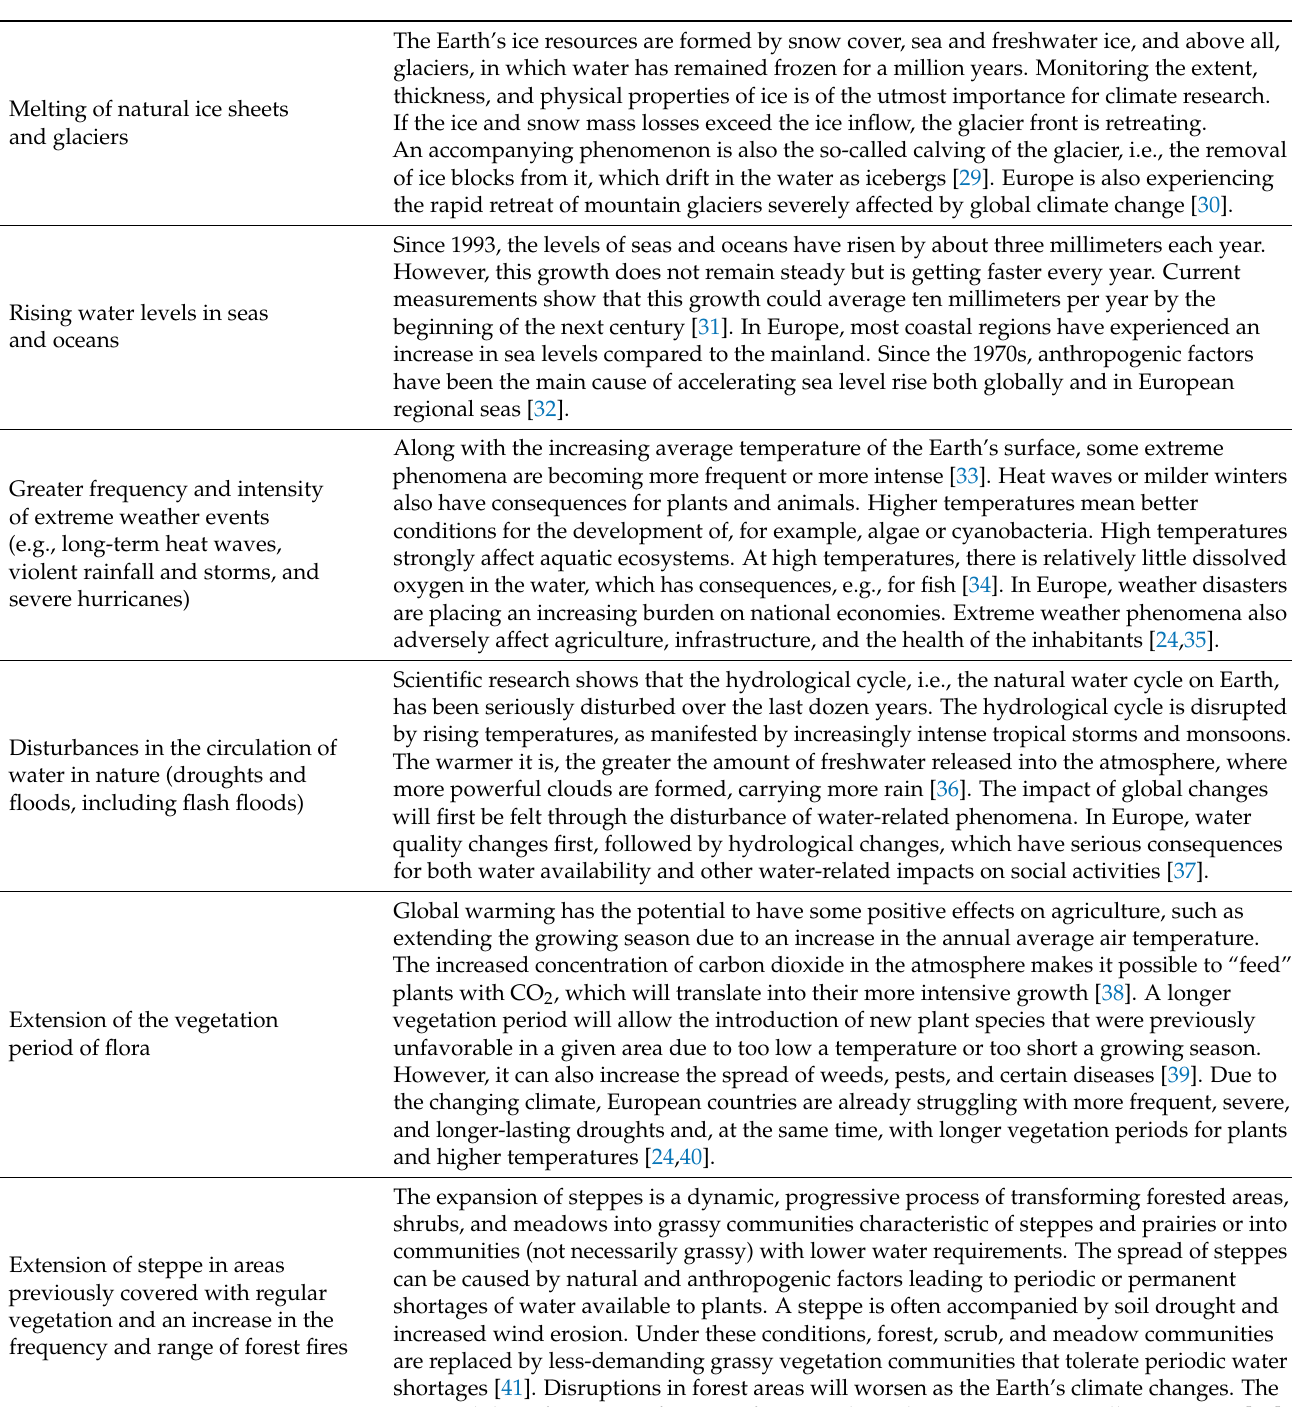
Table 2. Threats related to global as well as European warming and their